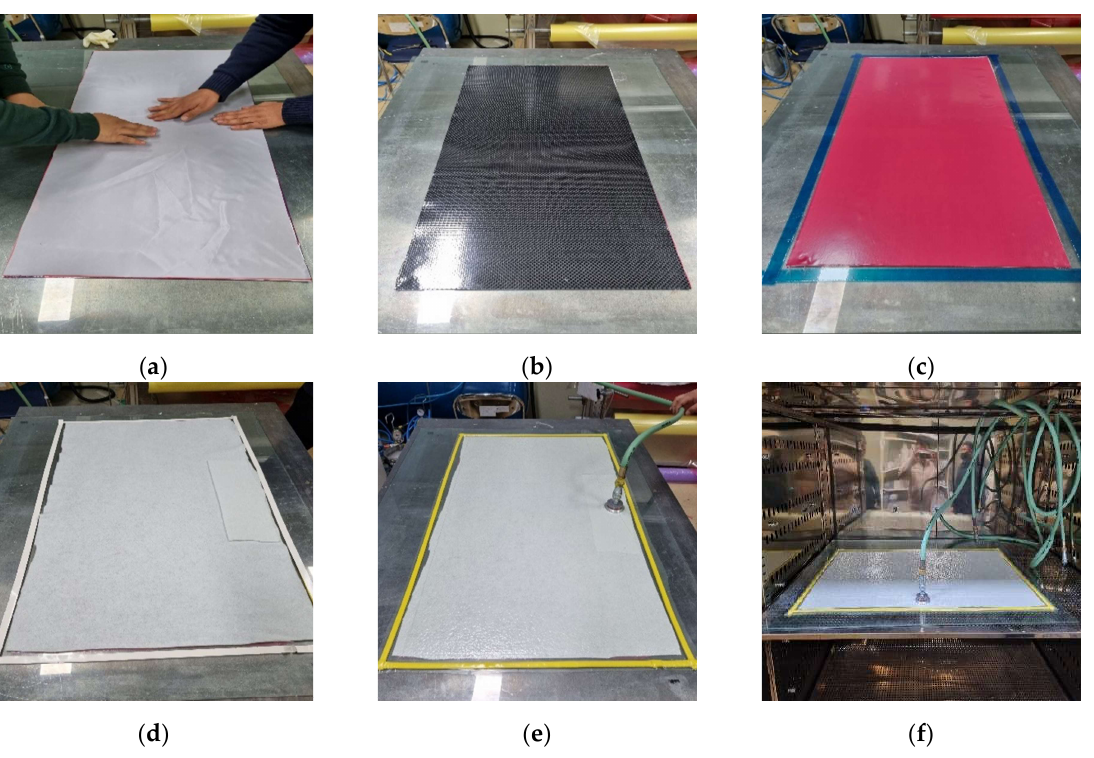
Figure 6. Specimen fabrication by prepreg OVB method. ( a ) Peel ply lamination. ( b ) Prepreg lamination. ( c ) Lamination of adhesive film and release film. ( d ) Lamination of breather fabric and vacuum film. ( e ) Compaction by vacuum bagging. ( f ) Oven curing during vacuum bagging.